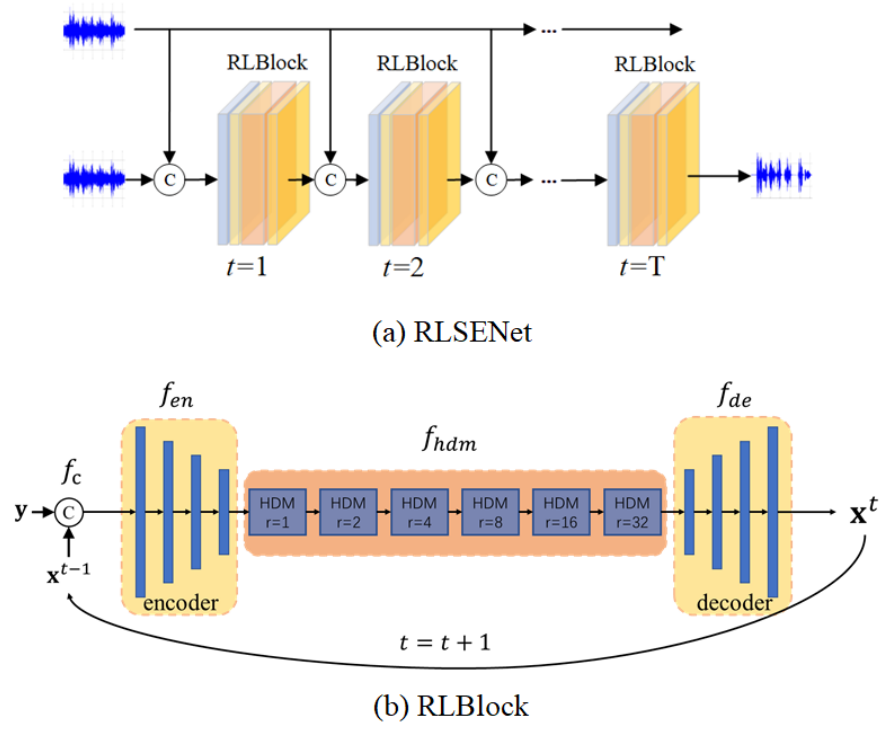
Figure 3. ( a ) RLSENet: recursive learning speech enhancement network, ( b ) RLBlock: recursive learning